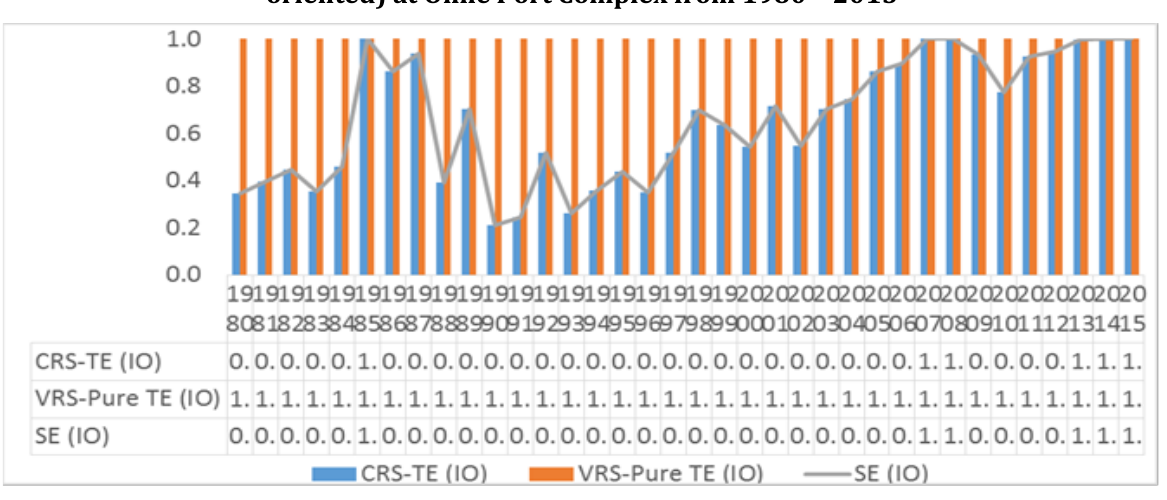
Figure 11: CRS – Technical Efficiency (Input-oriented) and CRS – Scale Efficiency (Input- oriented) at Onne Port Complex from 1980 –